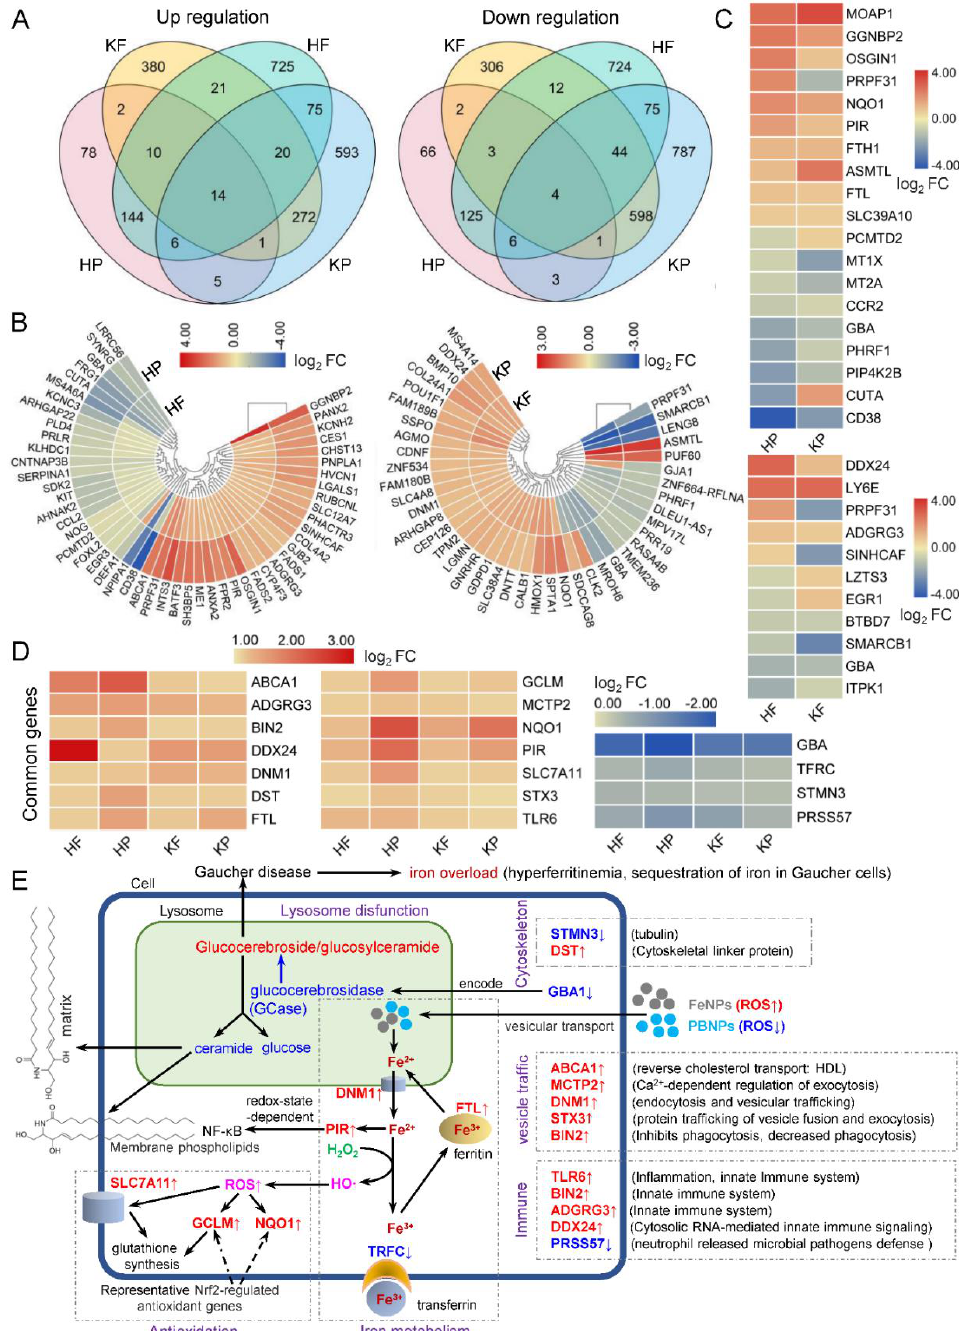
Figure 2. Comparisons of differentially expressed genes (DEGs) in two Leukemia cells treated with two kinds of iron nanoparticles: ( A ) number of upregulated and downregulated DEGs (fold change > 1.0) in the PBNP- and FeNP-treated HL60 and KG1a cells and their relationship, ( B ) common DEGs (fold change > 1.5) in a cell treated by two kinds of nanoparticles, ( C ) common DEGs (fold change > 1.5) in two cells treated by a nanoparticle, ( D ) common DEGs (fold change > 1.0) in two cells treated by two kinds of nanoparticles, and ( E ) schematic of cellular functions of common DEGs (fold change > 1.0) in two cells treated by two kinds of nanoparticles. The detailed information of all DEGs is shown in File S1 (Supplementary Materials). HF, FeNP-treated HL60 cells; HP, PBNP-treated HL60 cells; KF, FeNP-treated KG1a cells; and KP, PBNP-treated KG1a cells.